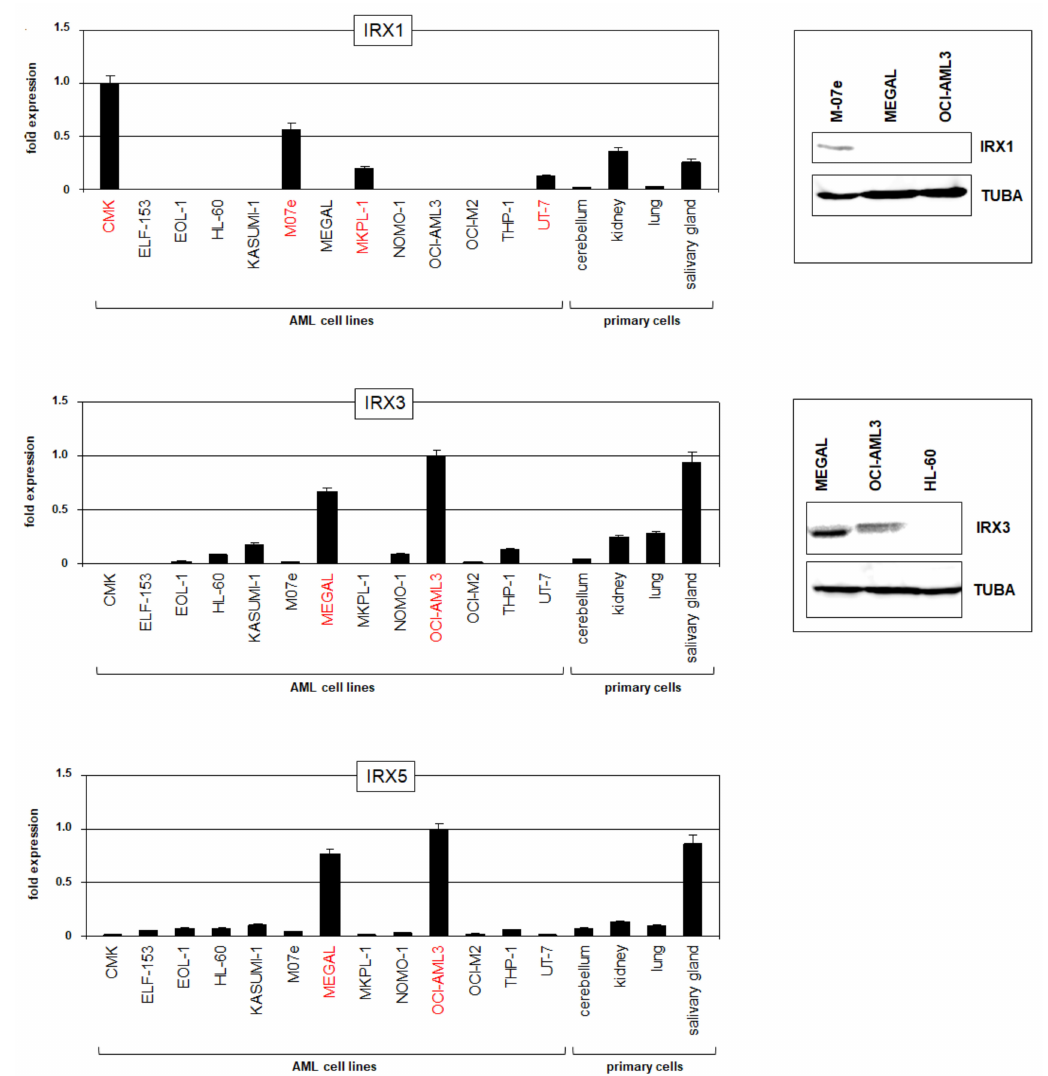
Figure 2. IRX gene activities in AML cell lines. Expression analyses of TALE homeobox genes IRX1, IRX3, and IRX5 in AML cell lines and primary controls as performed by RQ-PCR ( left ). Cell lines showing significant expression levels of the corresponding IRX genes are shown in red. P-values are indicated by asterisks. Western blot analyses ( right ) were performed for IRX1 and IRX3 in selected AML cell lines. TUBA served as loading